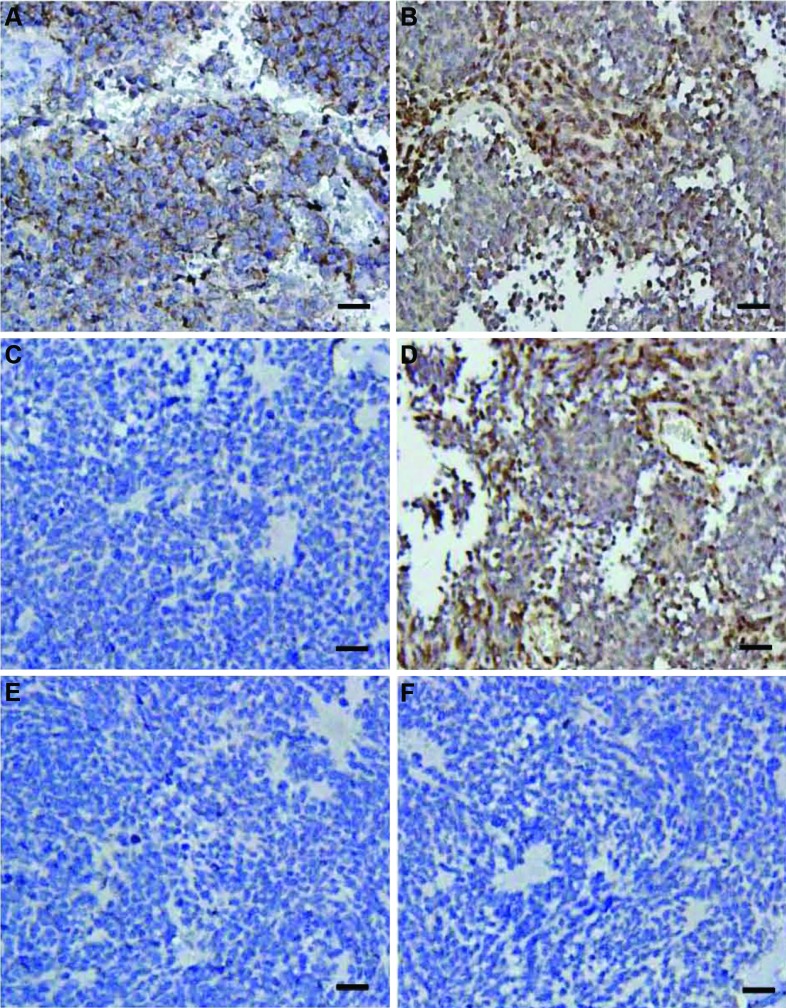
Immunohistochemical analyses of YAP and GAB1 to identify medulloblastoma subtypes. (A, B) The SHH subtype was positive for both (A) YAP1 and (B) GAB1. (C, D) The WNT subtype was positive for (C) YAP1 and negative for (D) GAB1. (E, F) The non-SHH/WNT subtype was negative for both YAP1 and GAB1. Magnification, 400×; scale bar, 50 μm.